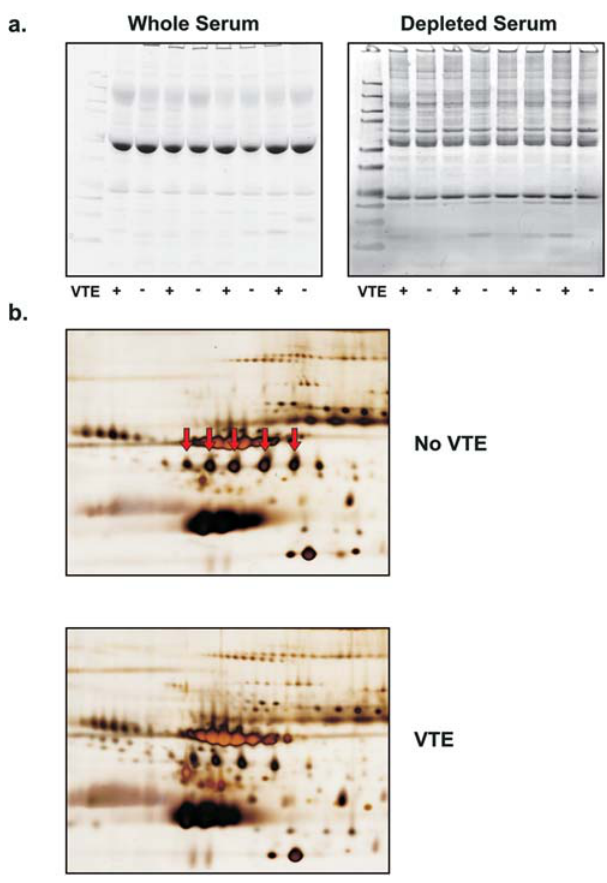
Figure 4. Gel electrophoresis of serum from patients with and without VTE. 1-DGE of whole serum and depleted, conditioned serum was run on 4 VTE and 4 NonVTE patients (a). 2-DGE was performed on serum from patients with VTE and without VTE, with arrows pointing to a series of haptoglobin proteins with differential expression between VTE and NonVTE patients, displayed in two representative gels (b).